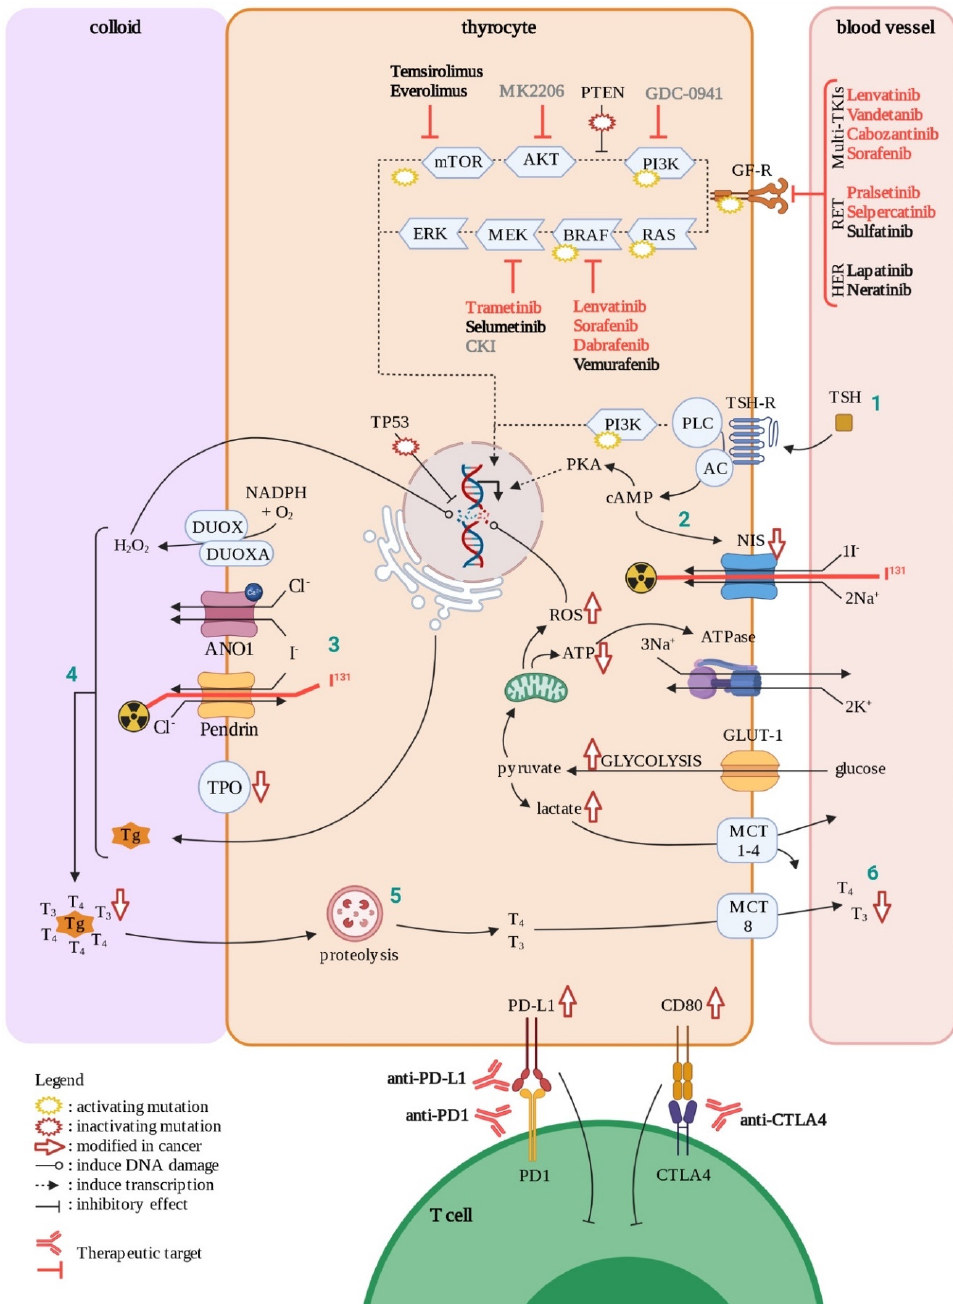
Figure 5. Thyroid cell in normal and cancer situations. In normal condition, thyrocytes produce thyroid hormones (T3 and T4) in response to TSH through several steps (1–6). During oncogenesis, mutations (with positive or negative effects on clone selection) and other factors will affect physiological functions in the cell (symbolized by red arrows). Approved treatments are in red, ongoing clinical trials are in black, and experimental drugs are in grey. GF-R; growth factor receptors, AC; adenylate cyclase, Tg; thyroglobulin, TPO; thyroid peroxidase. Created with BioRender.com (accessed on 4 January